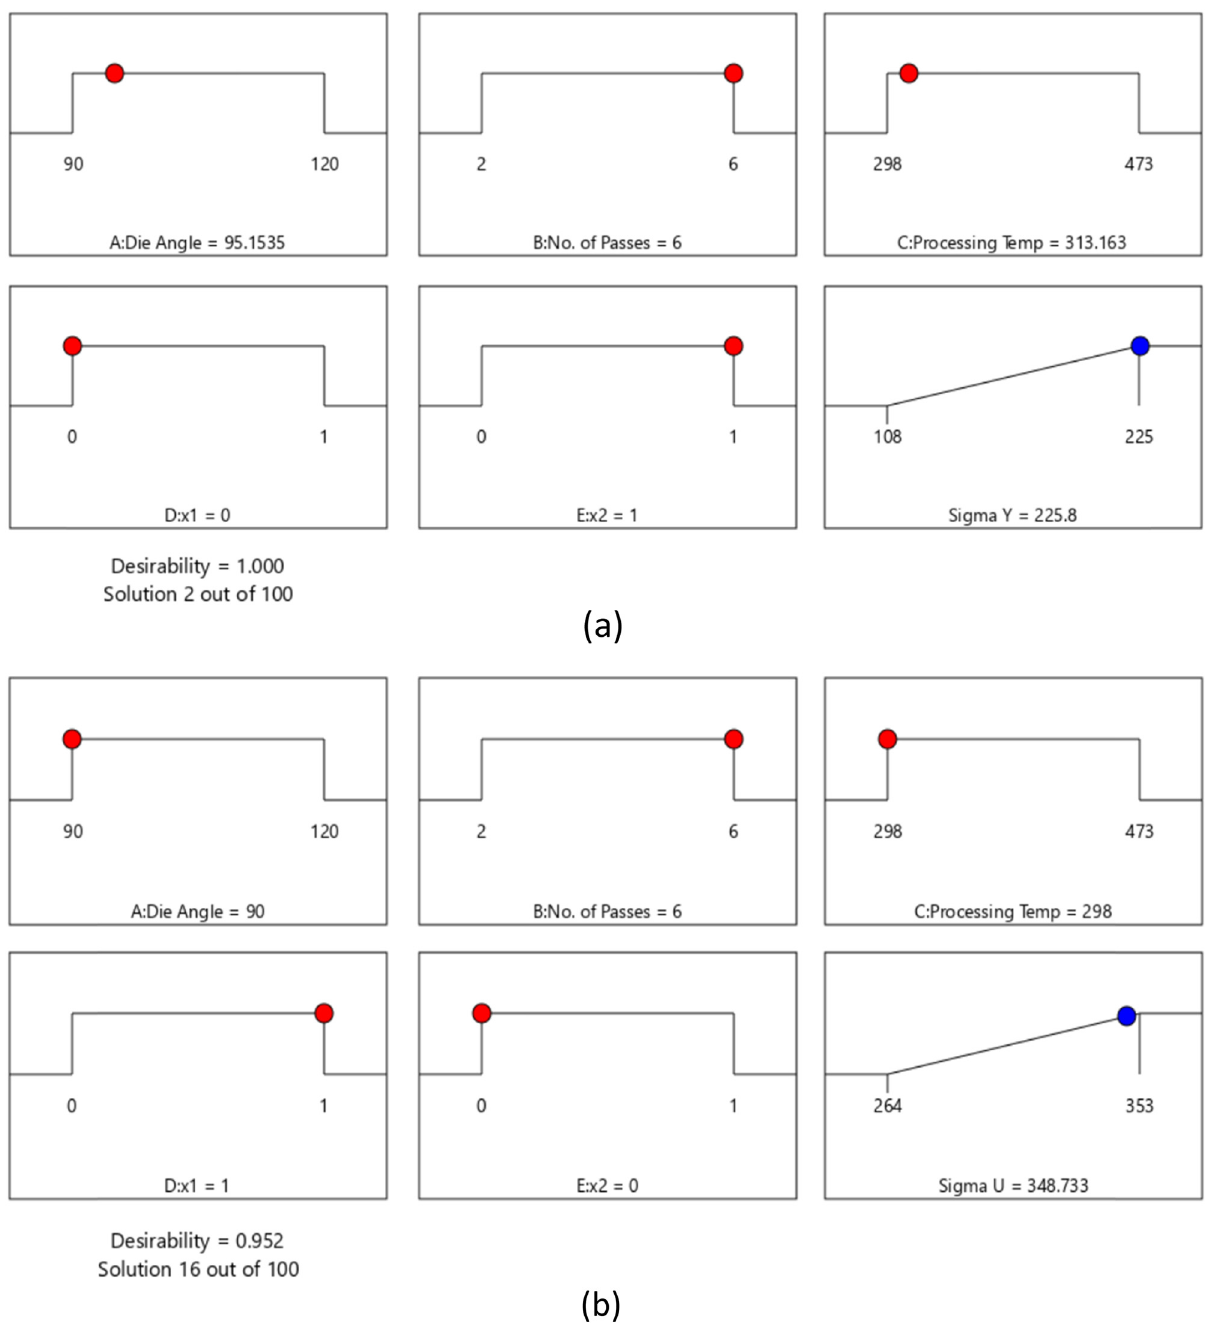
Figure 20: RSM optimization results of ( a ) σ y and ( b ) σ u